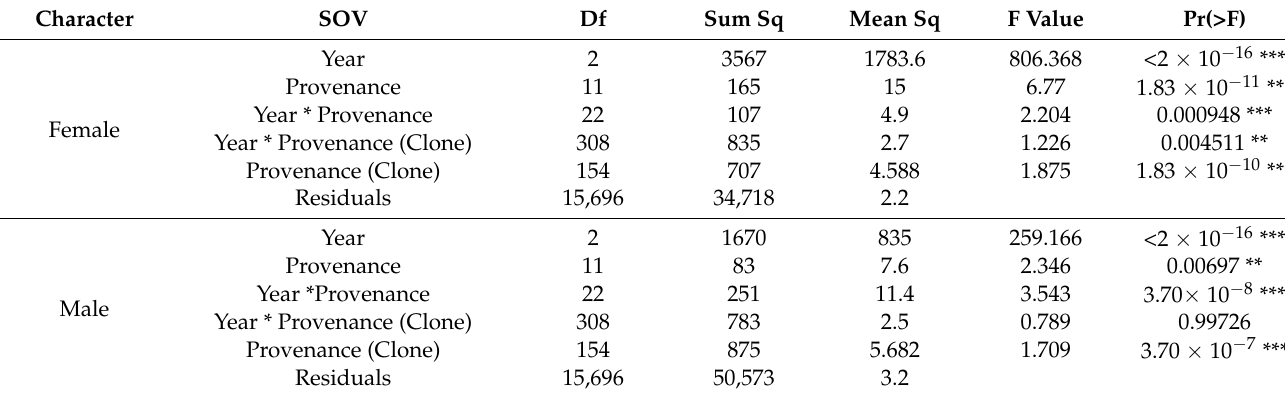
Table 1. ANOVA of P. orientalis female and male strobili production across years, provenance, and clones.